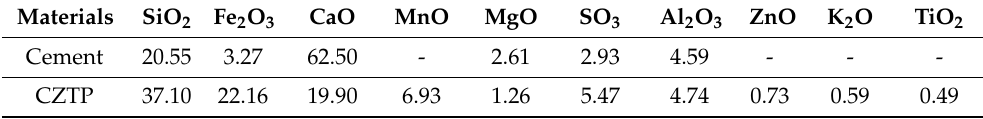
Table 1. Chemical composition of unmodified and modified copper and zinc tailing powder (wt.%). Materials